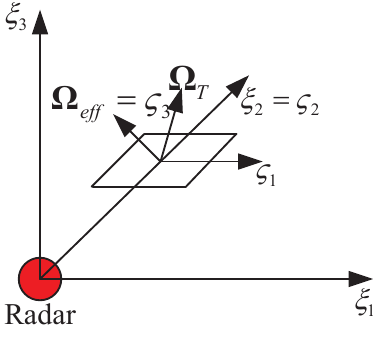
Figure 2. The ISAR imaging